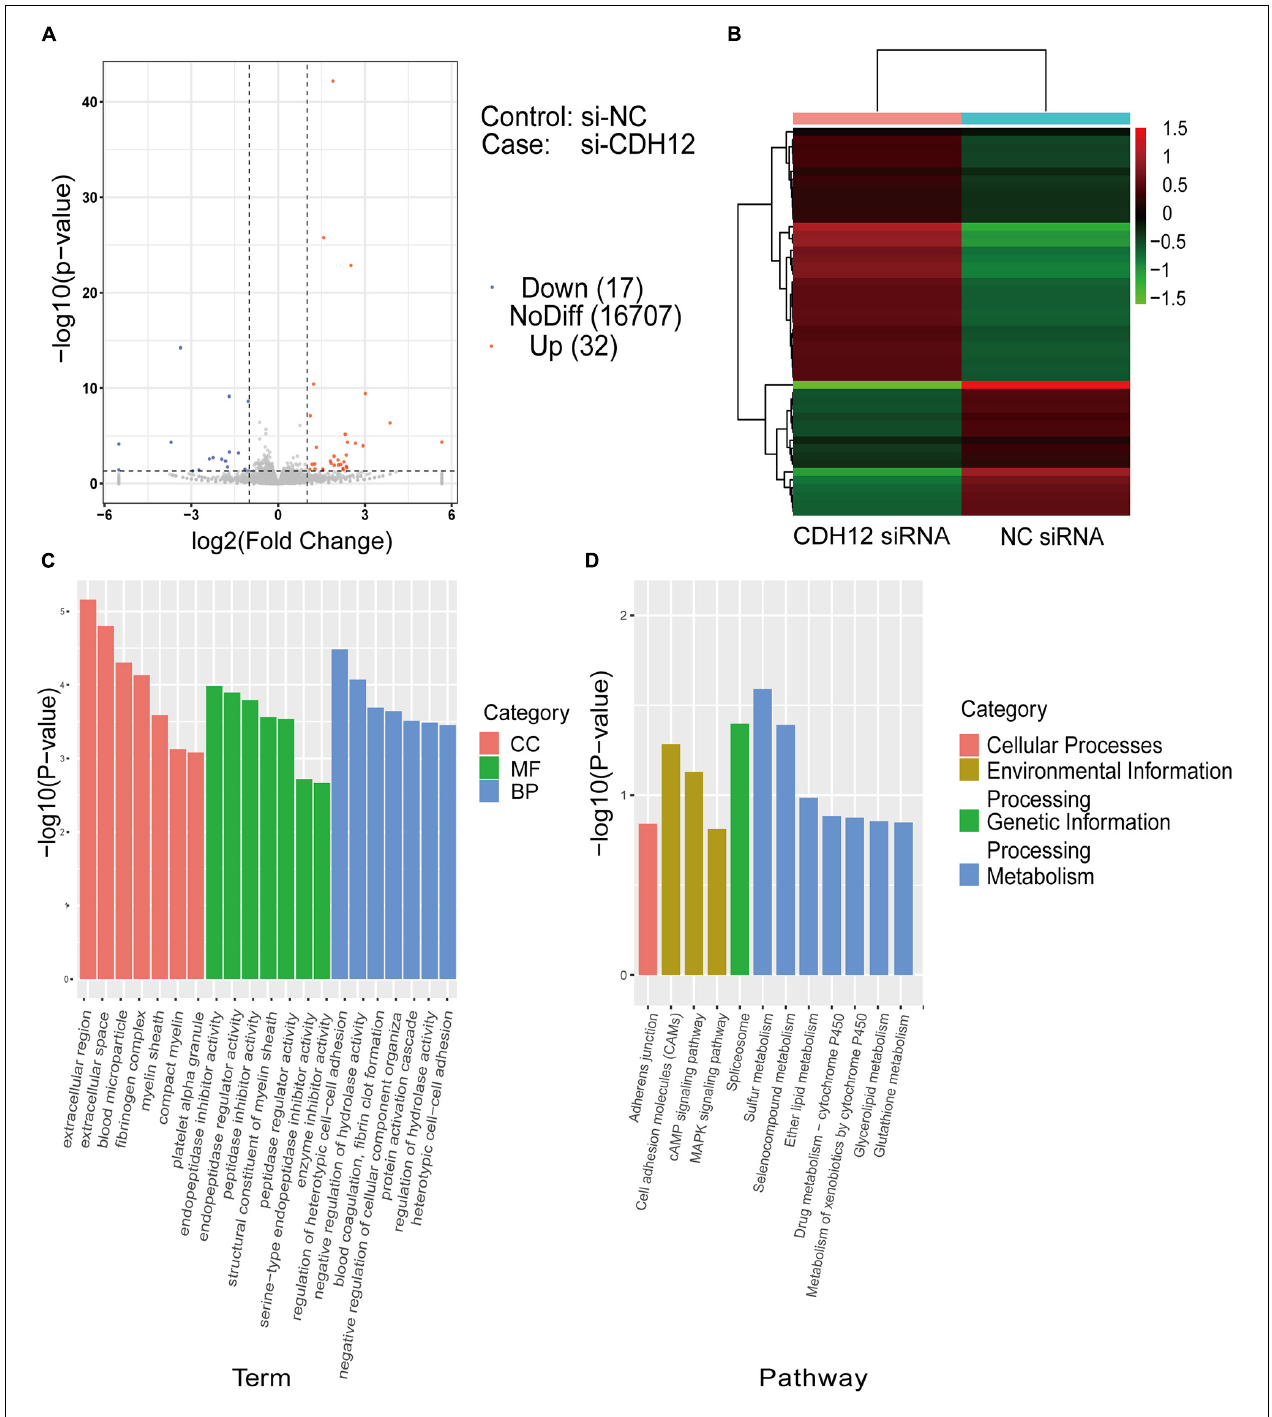
FIGURE 2 | RNA sequencing and DEG analysis of E18 cortical neurons with or without CDH12 knockdown. (A) Volcano map of DEGs between two groups of cortical neurons. A total of 32 and 17 genes were significantly upregulated (red dots) and downregulated (blue dots) after CDH12 knockdown, respectively. (B) Hierarchical clustering analysis of DEGs of cortical neurons with or without CDH12 knockdown treatment. (C) The top 20 enriched GO terms of the 49 DEGs. CC: cellular component, MF: Molecular function, BP: Biological process. (D) The most significantly enriched KEGG pathways of the downregulated genes. The top three enriched pathways of “Environmental Information Processing” are Cell adhesion molecules (CAMs), cAMP pathway, and MAPK pathway.